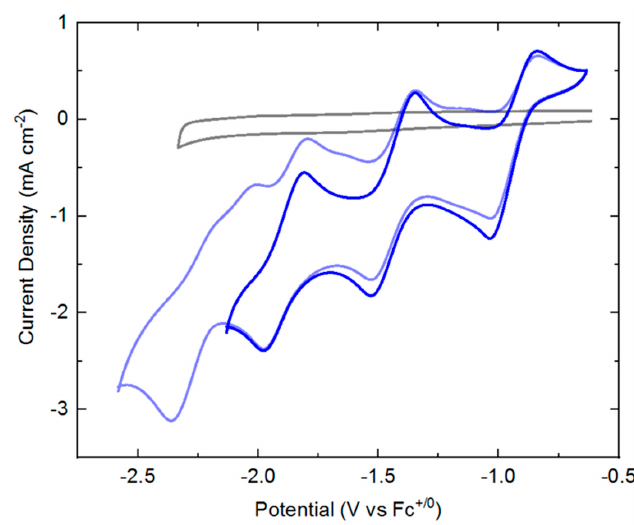
Figure 2. Cyclic voltammograms of 3 . Scan rate: 100 mV/s. Dark blue line: Cathodic sweep from ca. − 0.6 V to a switching potential of − 2.2 V and returning to − 0.6 V. Light blue line: Cathodic sweep from ca. − 0.6 V to a switching potential of − 2.6 V and returning to − 0.6 V. Gray line: electrolyte-only blank. Conditions: [ 3 ] ≈ 1 × 10 − 3 M; electrolyte: 0.1 M [NBu 4 ][PF 6 ] in tetrahydrofuran (THF). Table 1. Cyclic voltammetry data for 3 . Conditions: [ 3 ] = 10 − 3 M; scan rate: 100 mV/s; electrolyte: 0.1 M [NBu 4 ][PF 6 ] in THF. Redox Event E 1/2